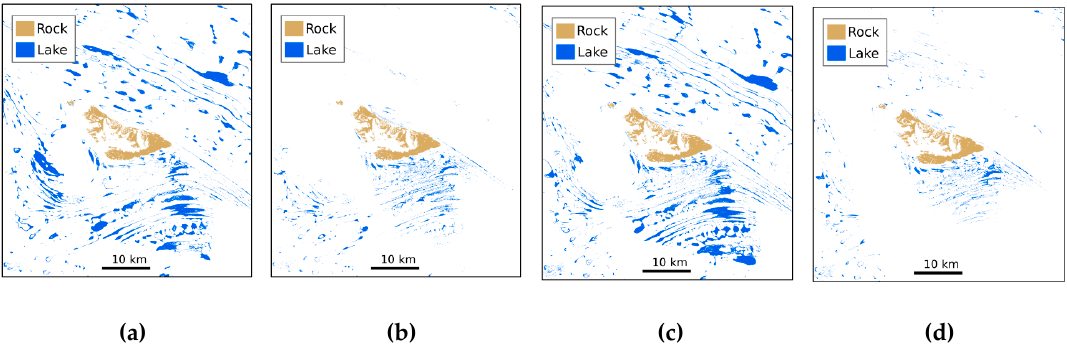
Figure 8. Maximum lake extent and rock outcrop maps for ROI 1 over Amery Ice Shelf during the 2017